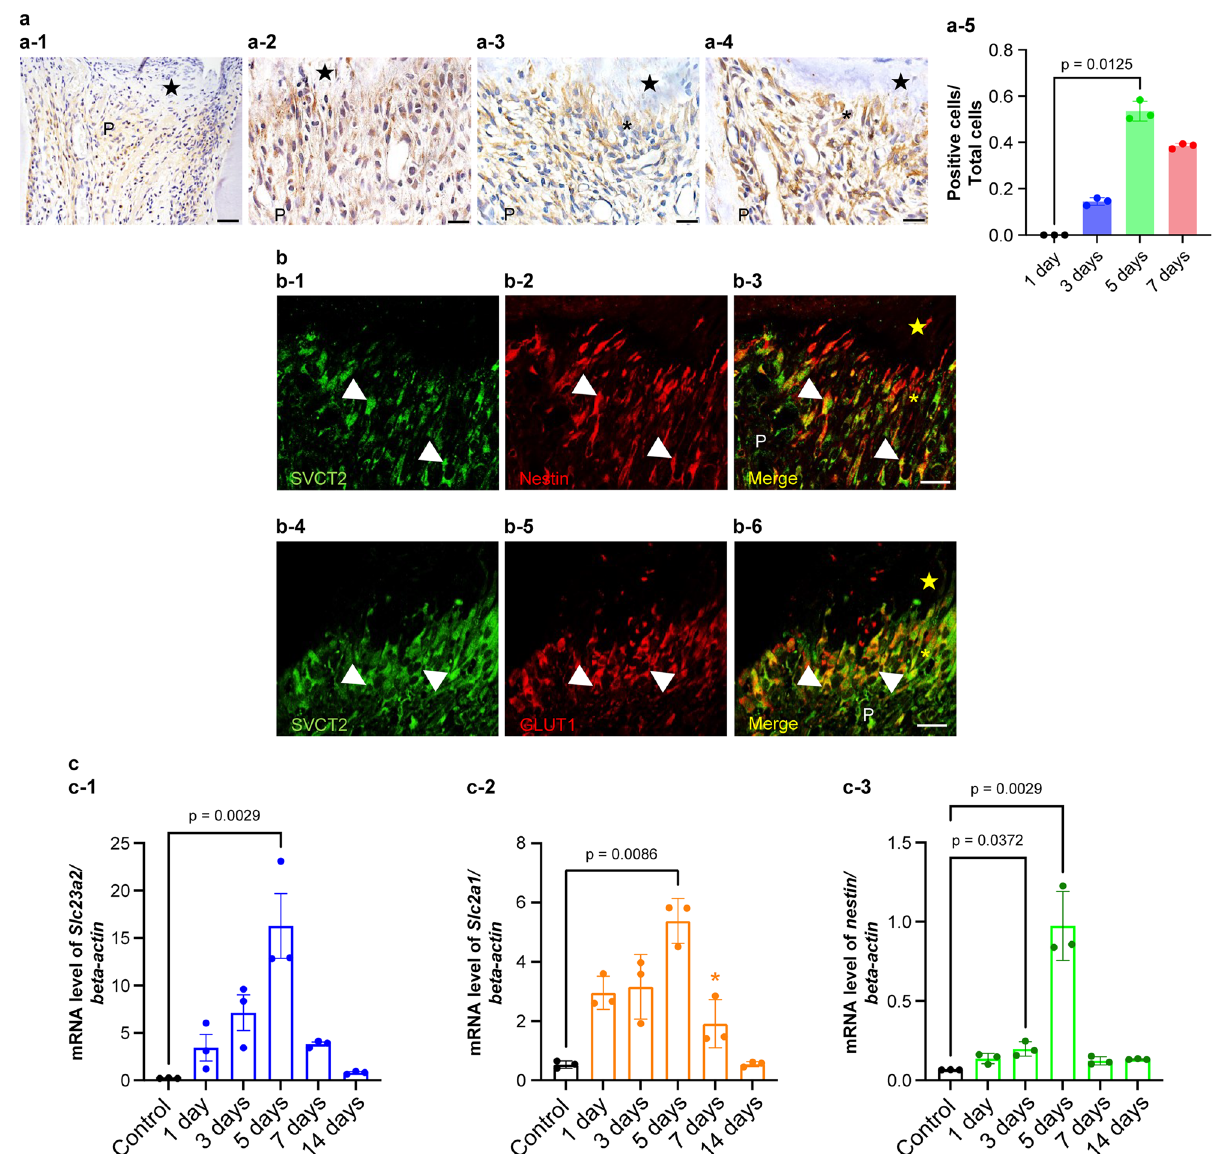
Figure 3. Alteration of SVCT2 expression over time in the pulp tissue after pulpotomy followed by MTA capping. ( a ) Immunohistochemistry of SVCT2 in the coronal pulp tissue of the injured teeth at (a-1) 1, (a-2) 3, (a-3 and b-1–b-6) 5, and (a-4) 7 days after pulpotomy (n = 3 at each time point). (a-2) At 3 days after pulpotomy, immunoreactivities of SVCT2 were seen throughout the pulp tissue. Reparative dentin initiated to be formed from (a-3) 5 days after pulpotomy. Immunoreactivities of SVCT2 detected the newly differentiated osteoblast- like cells below the reparative dentin at (a-3) 5 and (a-4) 7 days after pulpotomy. ( b ) SVCT2 localization is recognized in the odontoblast-like cells 5 days after pulpotomy. (b-1 and b-4) SVCT2 staining (Green). (b-2) Nestin staining (odontoblast marker, red). (b-5) GLUT1 staining (Red) (b-3 and b-6) Merged images. The arrowheads indicate odontoblast-like cells that represented double positivity for SVCT2 and Nestin. ( c ) Slc23a1 (cording SVCT2), Slc2a1 (cording GLUT1), and Nestin mRNA expression in rat first molars after pulpotomy followed by MTA capping. Real time PCR used to quantify (c-1) Slc23a1 , (c-2) Slc2a1, and (c-3) Nestin mRNA levels in normal first molar tissue and at each analyzed time point after pulpotomy. Data exhibit the mRNA expression levels of Slc23a1 , Slc2a1, and Nestin normalized to β-actin mRNA level. Bars exhibit mean values ± standard error of the mean compared with controls (n = 3 for each group; only comparisons with p -value ≤ 0.05 are shown), Kruskal–Wallis test followed by Dunn’s post hoc test. All mRNA levels peaked 5 days after pulpotomy. The closed star indicates the area exposed by a bur and capped with MTA. The asterisks indicate the odontoblast-like cell layer. The closed stars indicate the necrotic layer or reparative dentin layer. P, pulp. Scale = 20